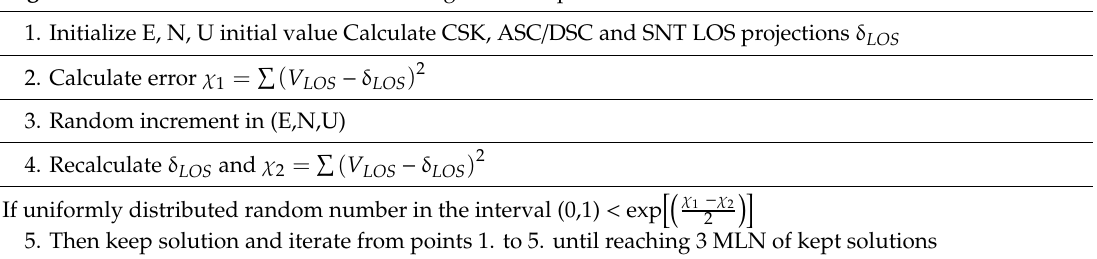
Algorithm 1. Markov Chain Monte Carlo Algorithm steps